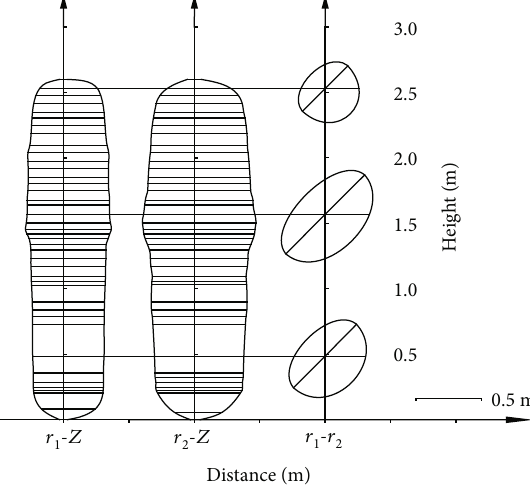
Figure 9: 9-03# hole section (drilling for hydraulic fl